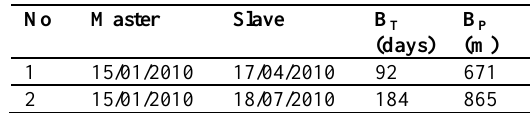
Table 1. Interferometric parameters for Yushu earthquake